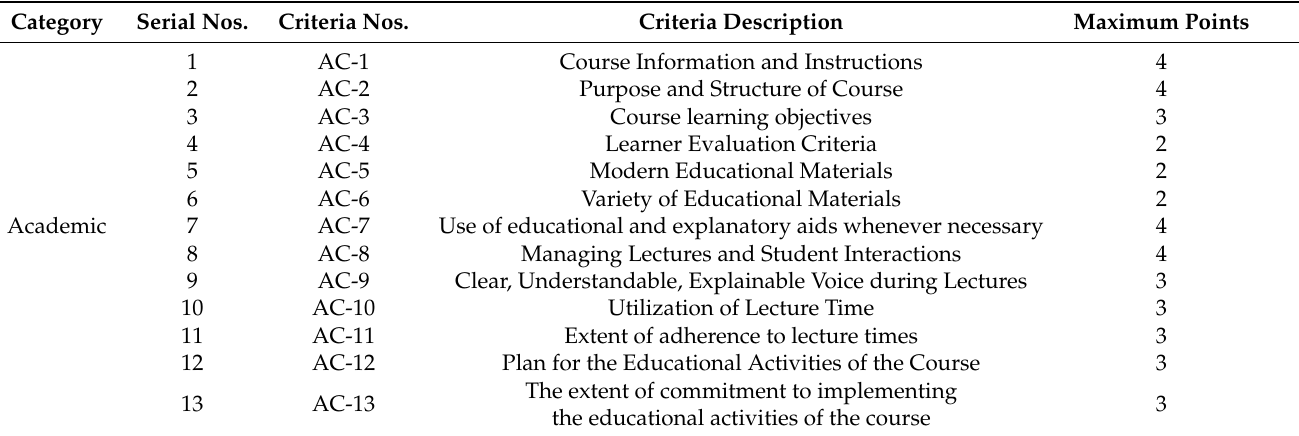
Table 2. QTEF—academic criteria.